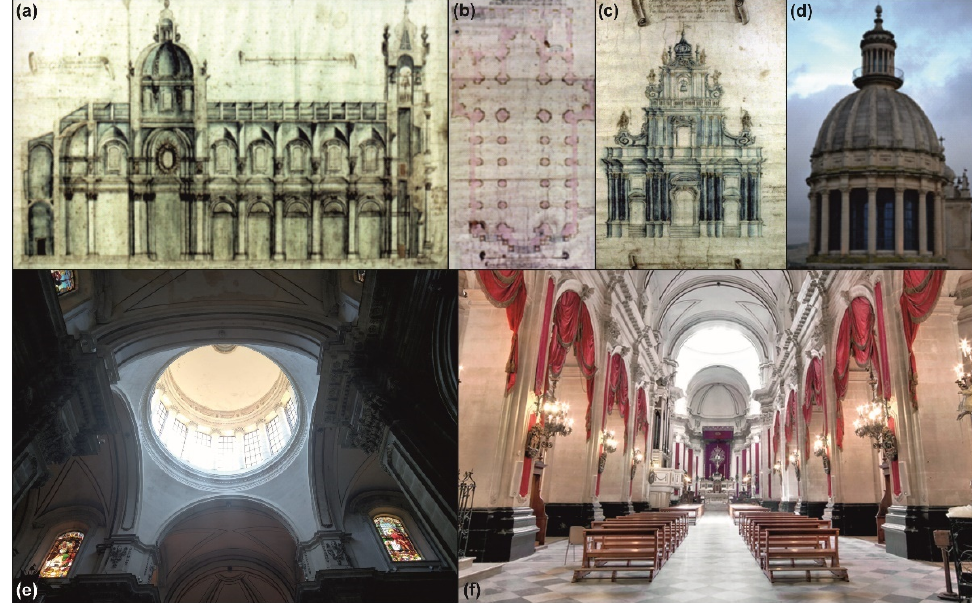
Figure 5. Gagliardi’s original drawings of nave ( a ), general layout ( b ), façade ( c ); view of the current dome from external ( d ) and internal perspective ( e ), view of the main nave ( f ).